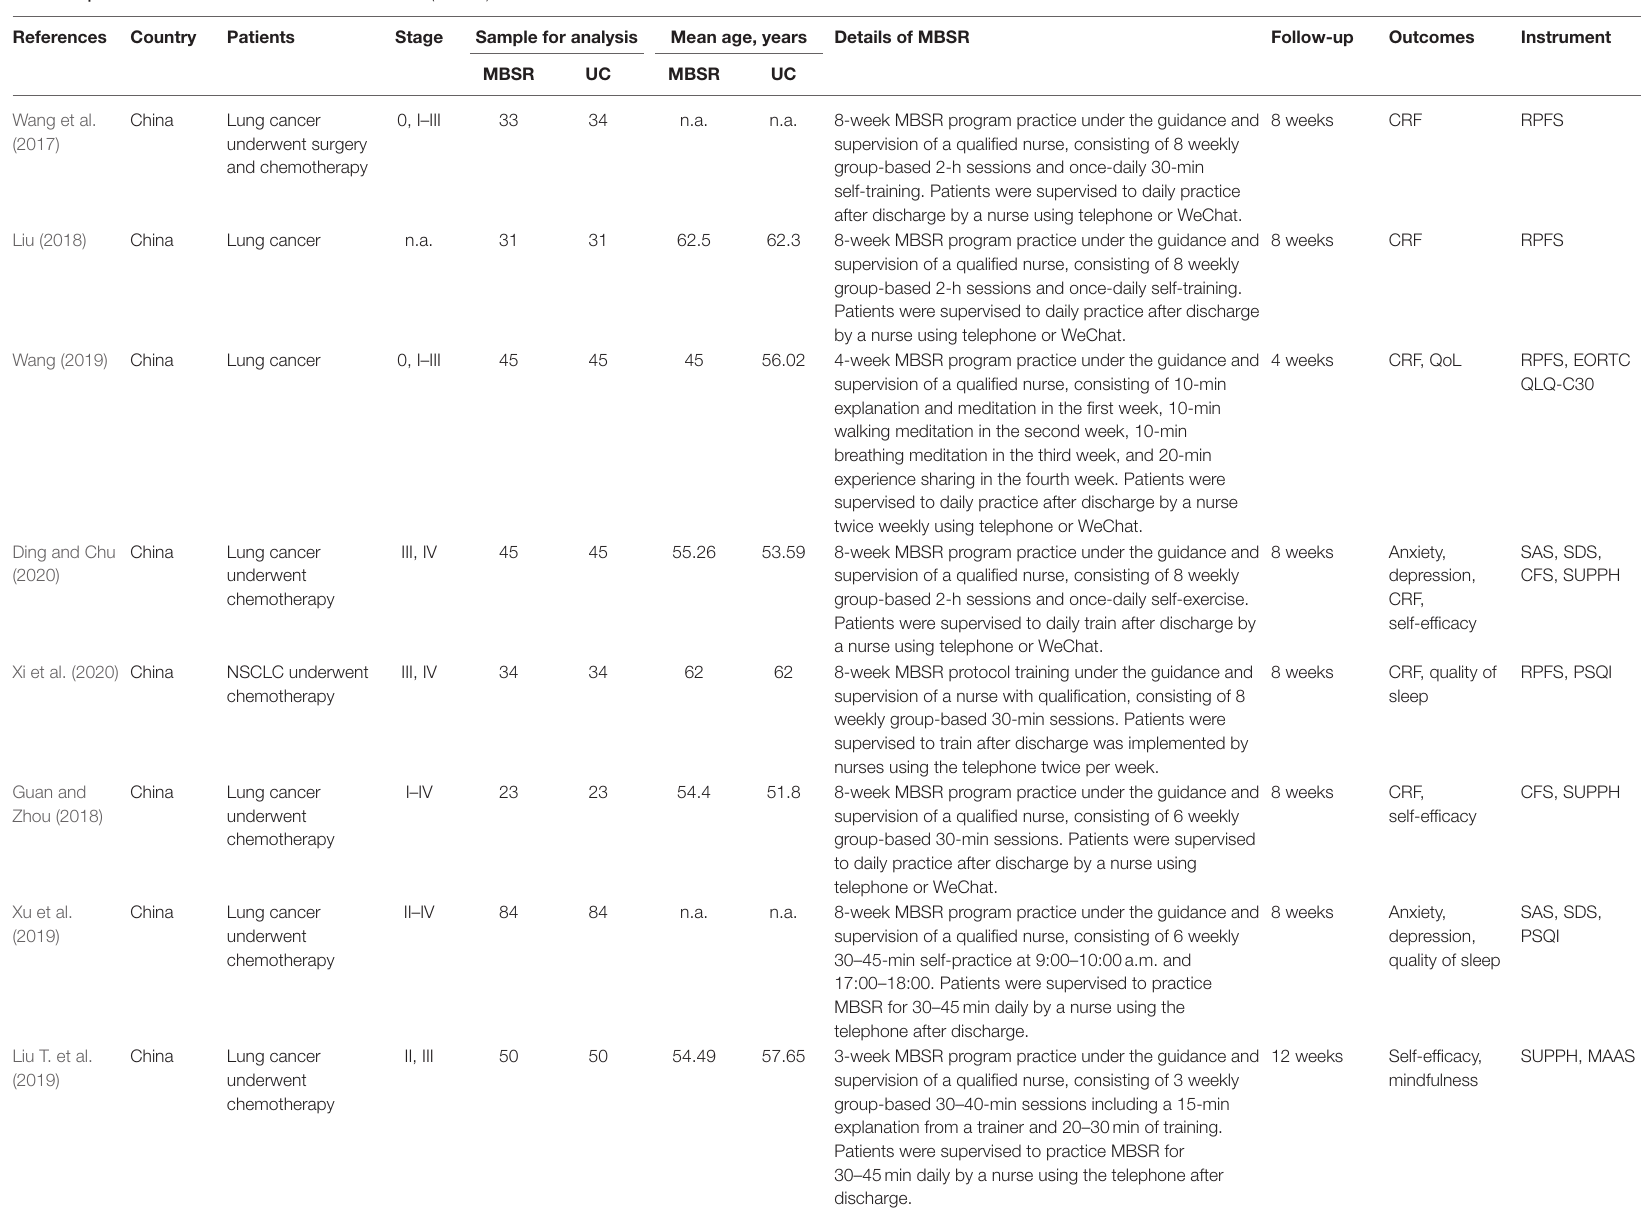
TABLE 1 | Basic characteristics of the included studies ( n =